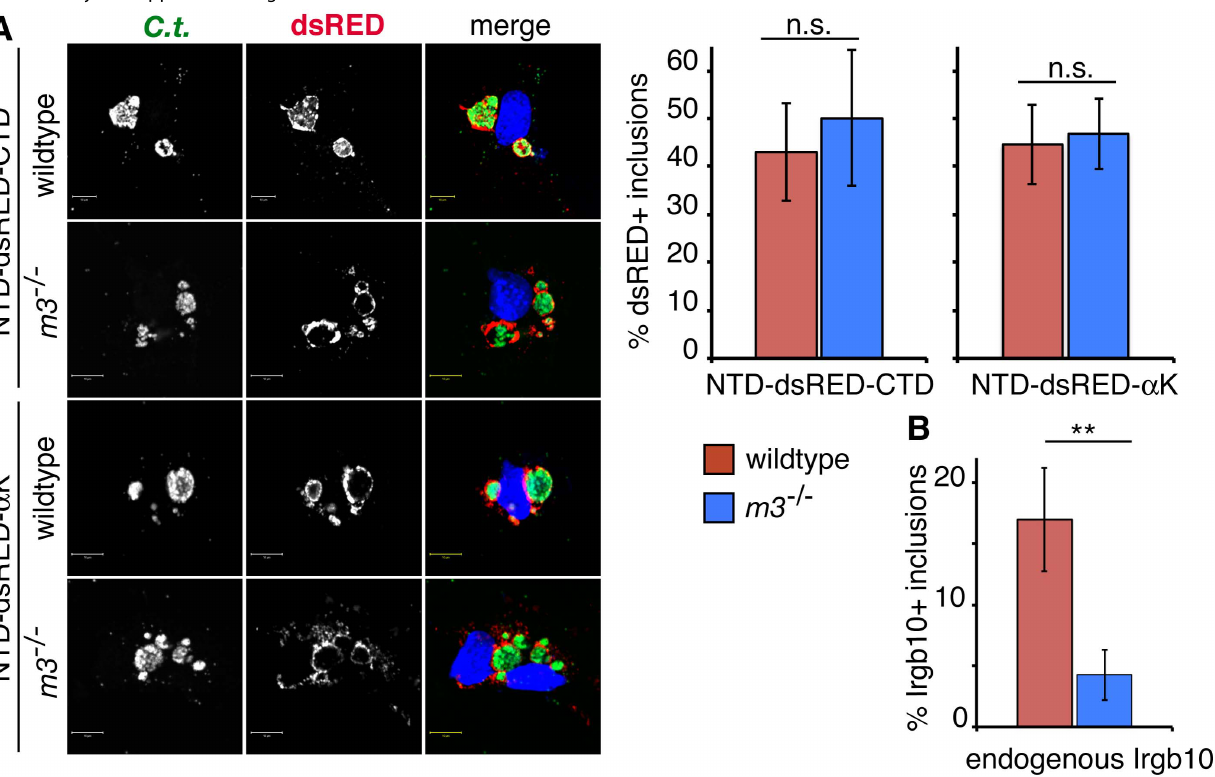
Figure 2. Tetramerized Irgb10 targets inclusions independently of Irgm3. ( A ) Wildtype and Irgm3 2 / 2 MEFs were transfected with Irgb10 NTD-dsRED-CTD or Irgb10 NTD-dsRED- a K , subsequently infected with C. trachomatis and treated with IFN c at 3 hpi. Fixed cells were stained with anti- C. trachomatis and Hoechst. The frequency at which dsRED fusions proteins co-locliazed with incluions inside transfected cells at 20 hpi was quantified in three independent experiments. Representative data from one experiment and images at 20 hpi are shown. Graph represents average values 6 SD. ( B ) Wildtype MEFs were infected with C. trachomatis , treated with IFN c at 3 hpi and the frequency of endogenous Irgb10 localizing to inclusions at 20 hpi was quantified. Error bars represent standard deviations. n.s.=not significant; **, p , 0.01.